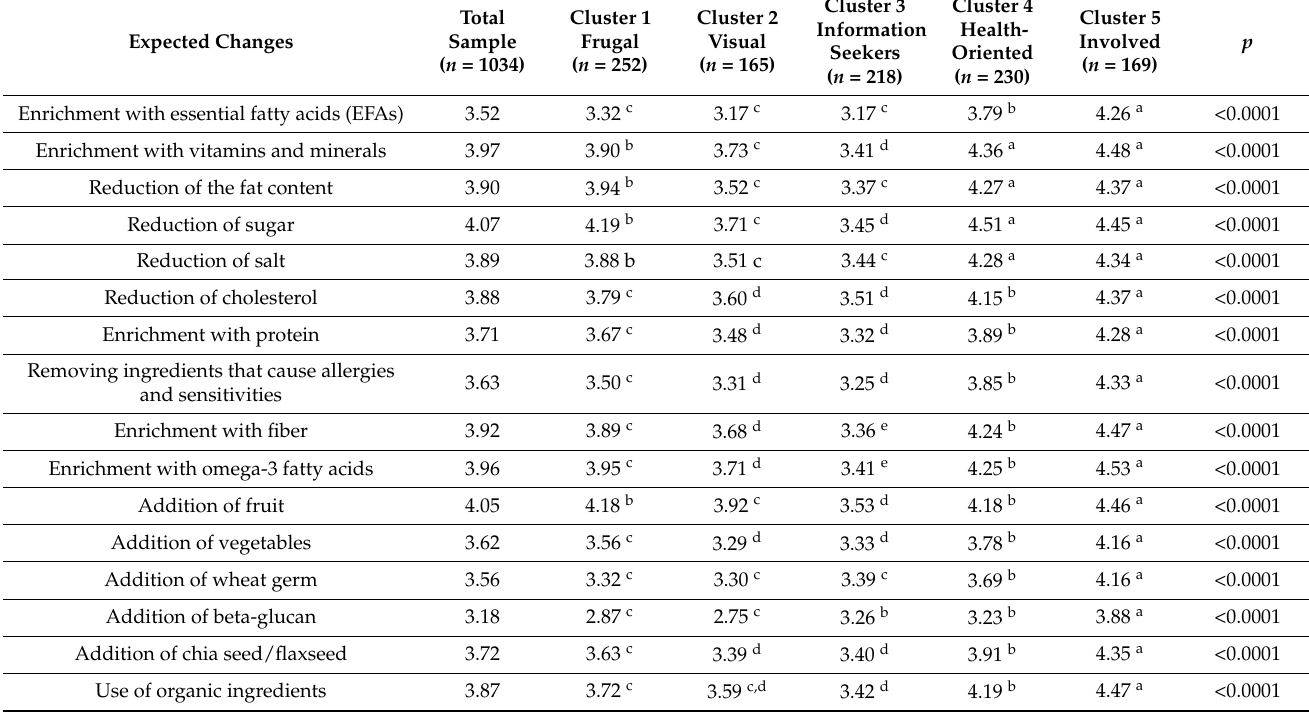
Table 6. Expected changes in fruit and cereal bars according to the clusters’ adherence (%, n = 1034,